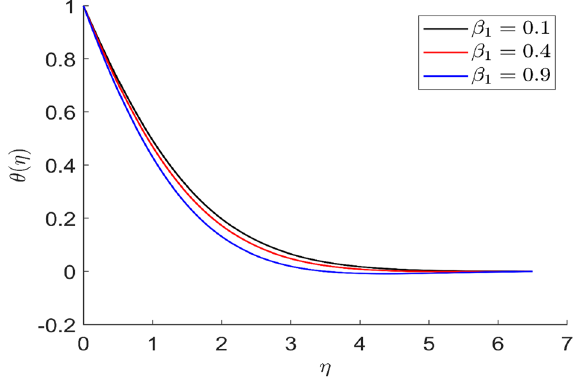
Figure 3. Representation of temperature θ(η) for the different values of β 1 (η) with R = 3, n = 3, v = 0.3, φ = 0.3, Pr = 0.6, φ 1 = 0.1, φ 2 = 0.8, m = 1.5, β = 0.4, β 2 = 0.5, β 3 = 0.5, u = 0.2, ξ =